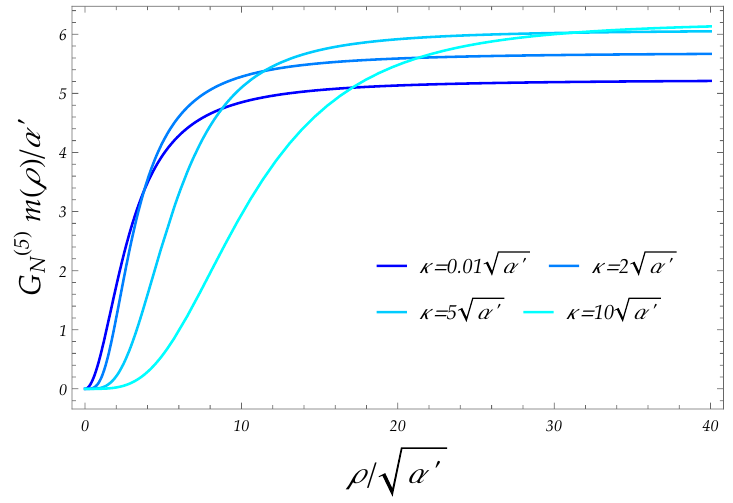
Figure 2 . Radial mass function of the global instanton solution for di(cid:11)erent values of (cid:20) 2 obtained by integration of the mass density function in (cid:12)gure 1 with respect to (cid:26) .